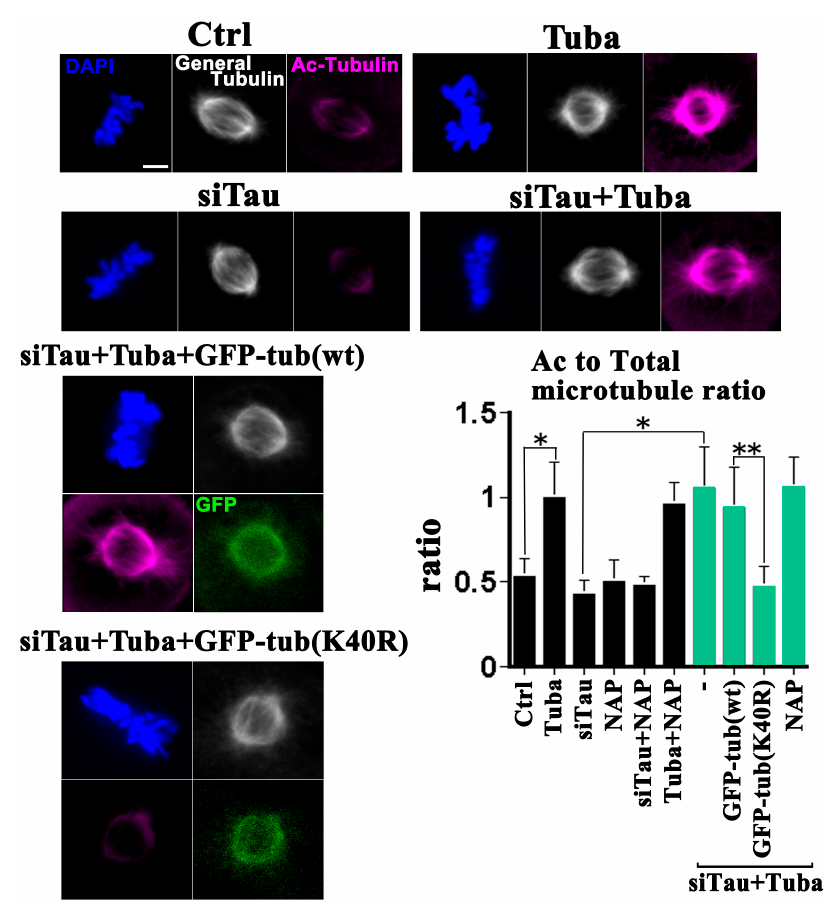
Figure 4. Mitotic effects of microtubule acetylation enhancement in tau knockdown human mammary epithelial cells (HMECs). Metaphase cells were selected for their condensed DNA morphology